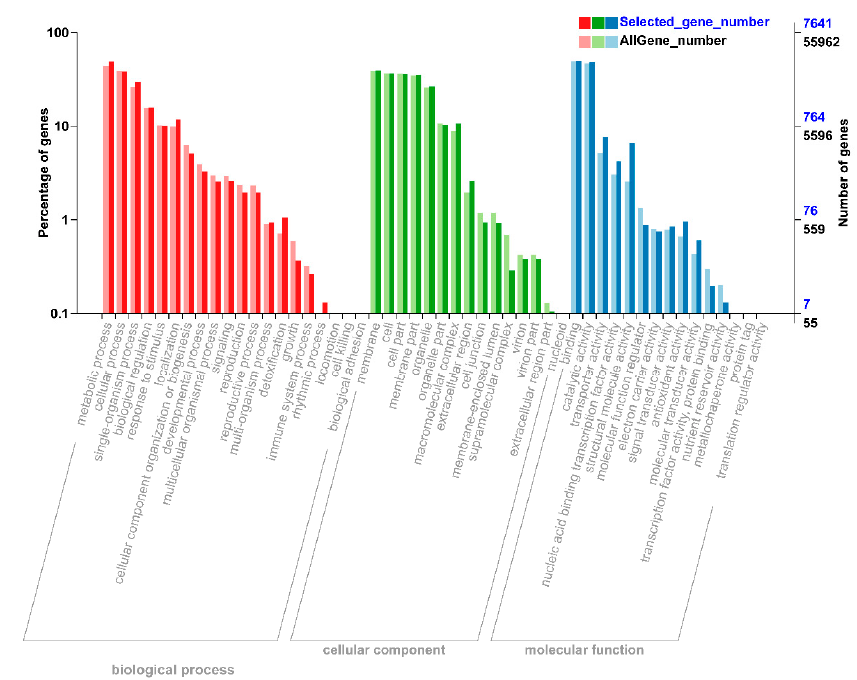
Figure 2. Di ff erential annotation gene ontology (GO) annotation classification chart. The abscissa is the GO classification, the left side of the ordinate is the percentage of the number of genes, and the right side is the number of genes. This figure shows the background of the di ff erentially expressed genes (DEGs) and the background of all genes. The DEGs were identified by pairwise comparisons between N-starvation and resupply treatments at p -value < 0.05. The gene enrichment of each secondary function of GO reflects the status of each secondary function in two contexts. The secondary function with obvious proportional di ff erence indicates that the di ff erentially expressed gene and the rich of all genes is rich.